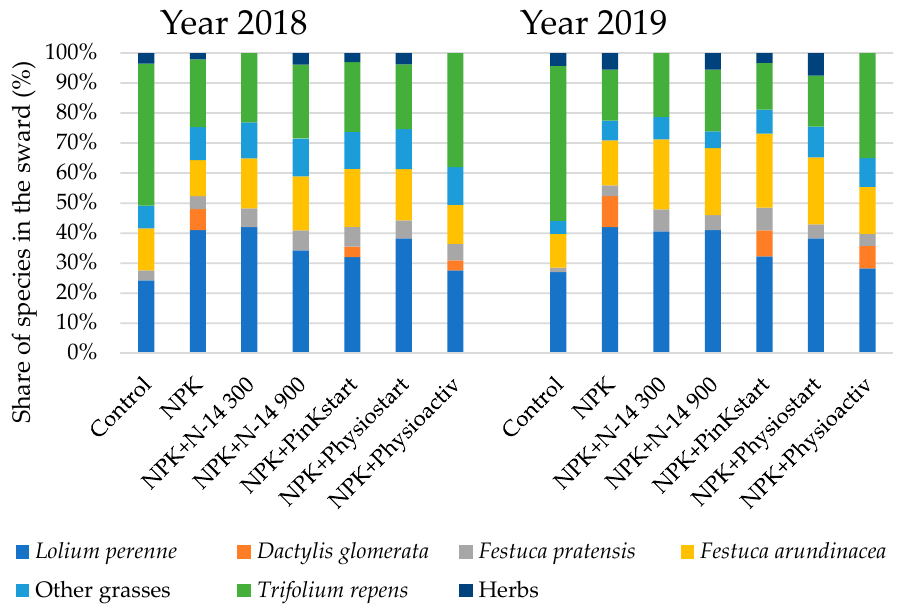
Figure 2. Percentage share in biomass of plant species in the legume-grass mixture (LGM) sward in 2018 and 2019 (average of three cuts).